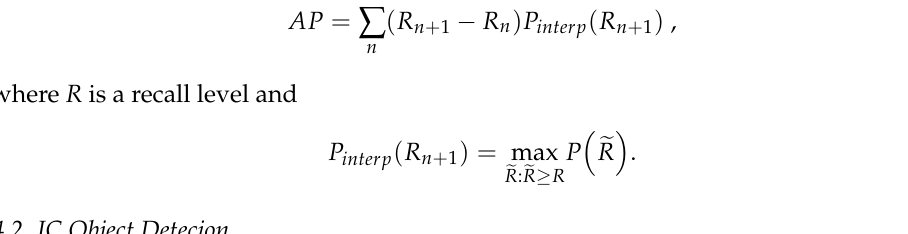
Figure 5. Some instances of the PCB DSLR Dataset. Table 2. Pixel area